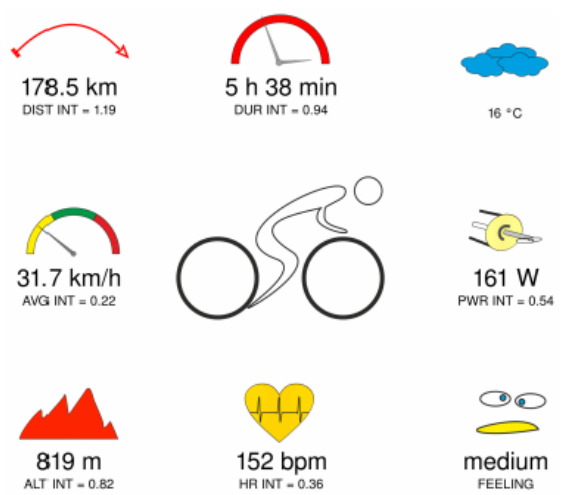
Figure 5. Figure shows the main basic parameters of sport training. The main basic parameters that are part of every cycling training are: total duration, total distance, temperature, average speed, altitude, power-meter values and average heart rate. Note: The Figure is reproduced with permission from